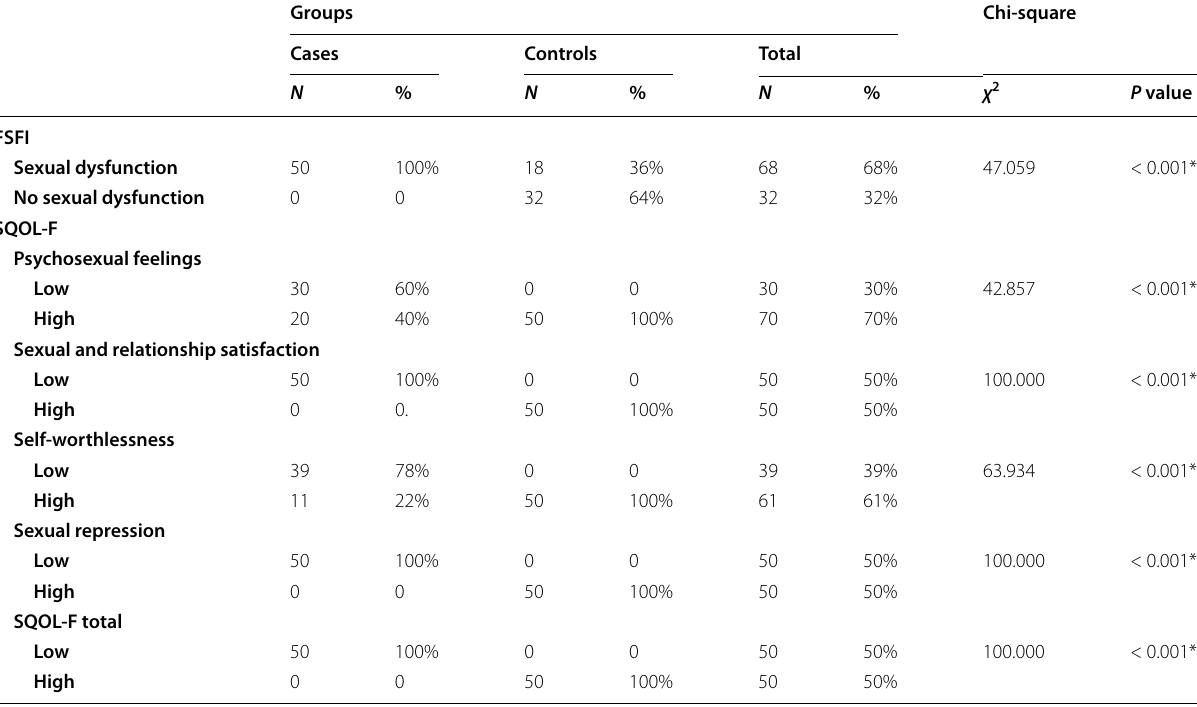
Chi-square test was used *Statistically significant ( P < 0.05) Table 4 The rate of distribution of WHO QOL scores in the case and control groups